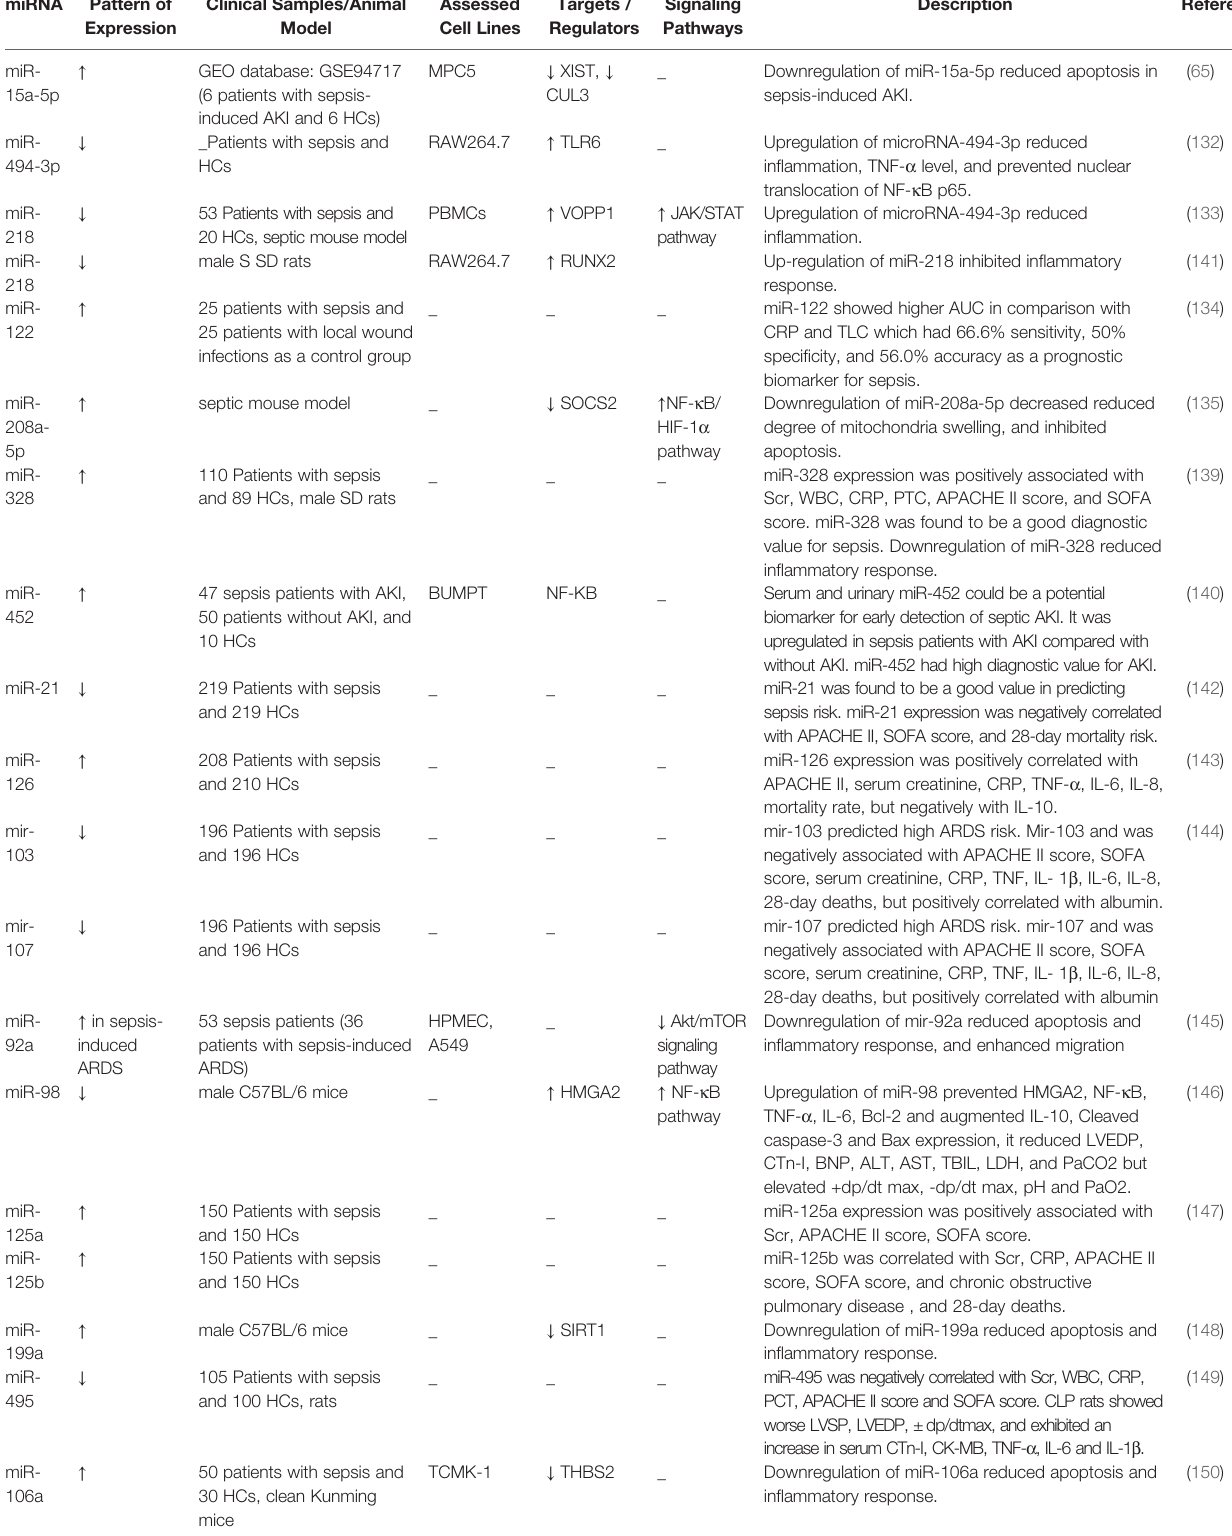
Assessed Targets / Signaling Cell Lines Regulators Pathways